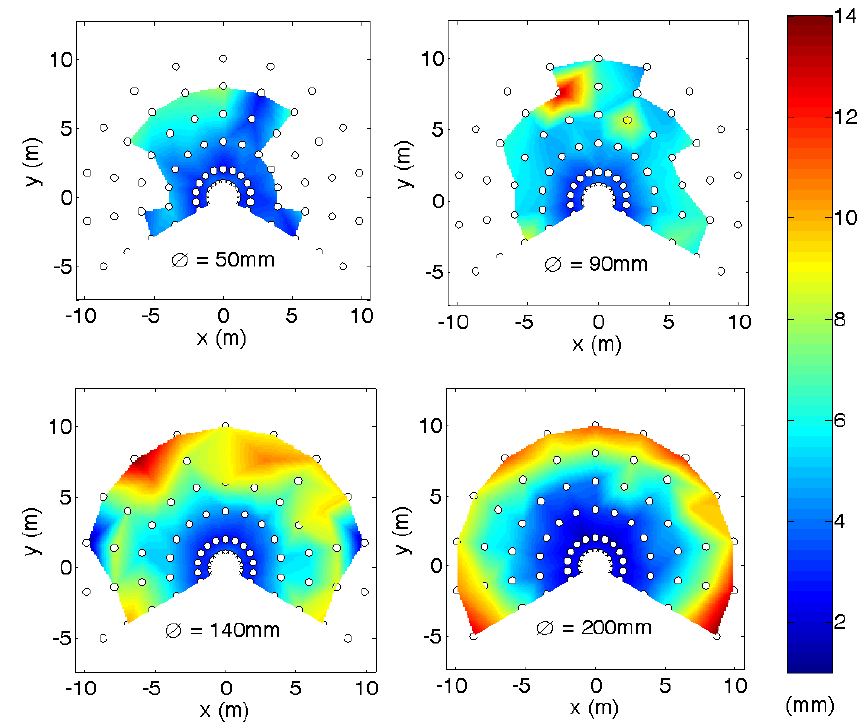
Figure 14. Standard deviation error map expressed in mm relative to the target